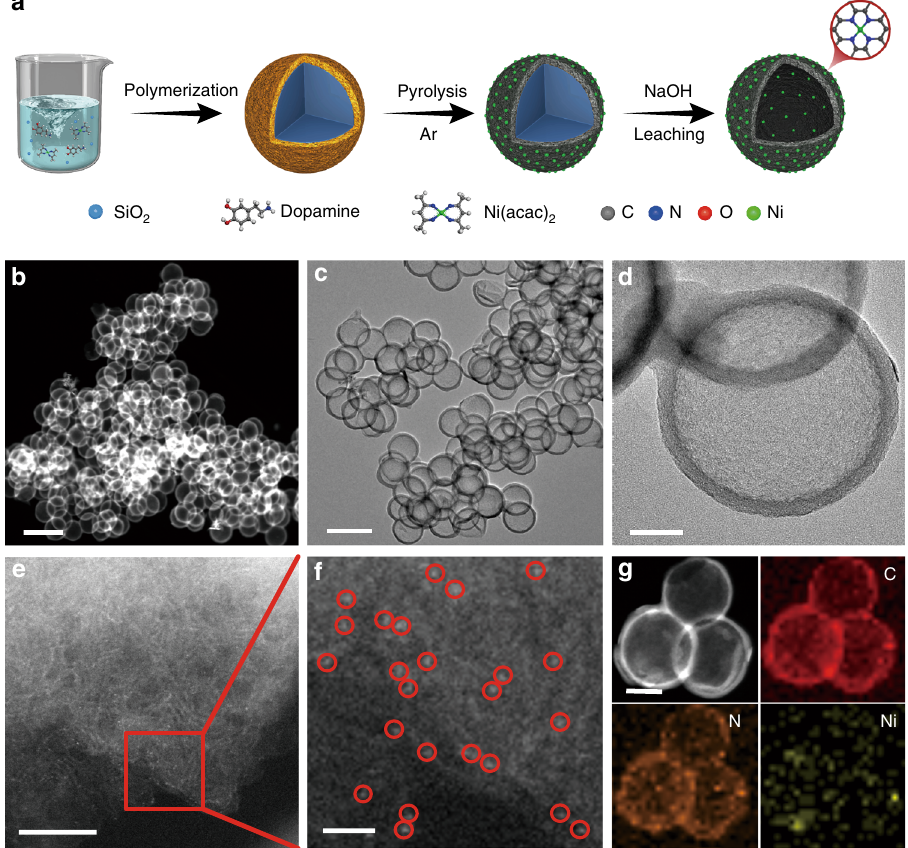
Fig. 1 Characterization of Ni SACs/N-C. a Schematic illustration of the synthesis of Ni SACs/N-C. b HAADF-STEM image of Ni SACs/N-C. Scale bar: 500 nm. c , d TEM images of Ni SACs/N-C. Scale bar: 300 nm in (c), 50 nm in ( d ). e , f AC-STEM images of Ni SACs/N-C. Ni single atoms were indicated by red circles. Scale bar: 5 nm in (e), 1 nm in (f). g HAADF-STEM image and corresponding EDX element mapping of the Ni SACs/N-C: C (red), N (orange) and Ni (yellow). Scale bar: 100